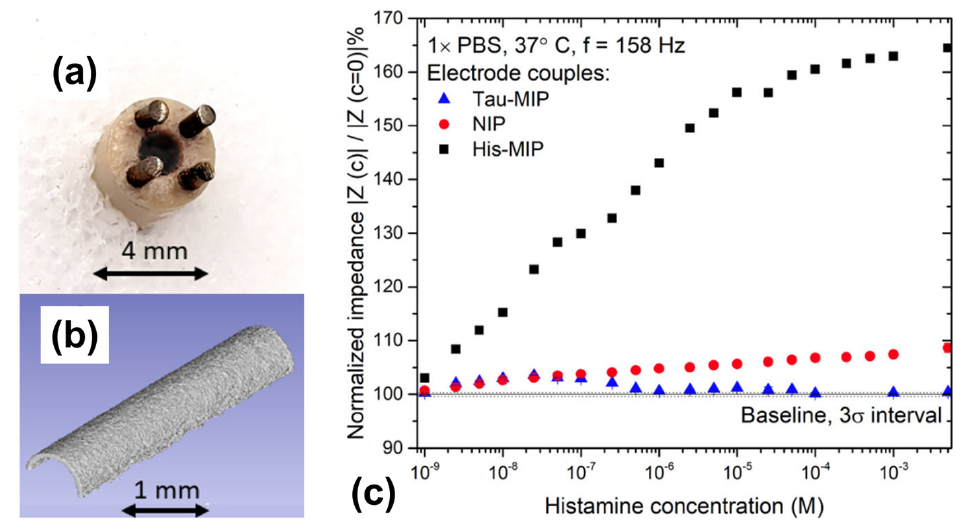
Figure 11. ( a ) Four-electrode configuration with two titanium pins coated with histamine-imprinted Ppy and two pins with a NIP coating for differential sensing in complex samples. ( b ) Optical coherence tomography reveals homogeneous Ppy coating with 1 µ m thickness. ( c ) The dose–response curve reveals an especially wide analytical range of the MIP electrodes to histamine and a negligible signal increase when the same histamine concentrations are applied to the NIP electrodes. For comparison, MIP layers were also synthesized with a taurine-sensitive coating, which did not show a quantifiable response to histamine, even for the highest concentrations. The figure is reproduced with permission from ref. [197], Copyright 2021 American Chemical Society.